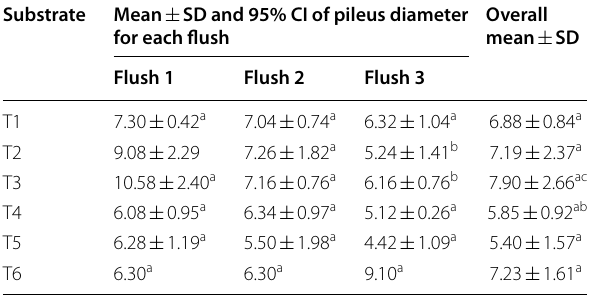
Mean values followed by different superscript letters within a row and columns are significantly different (p < 0.05)